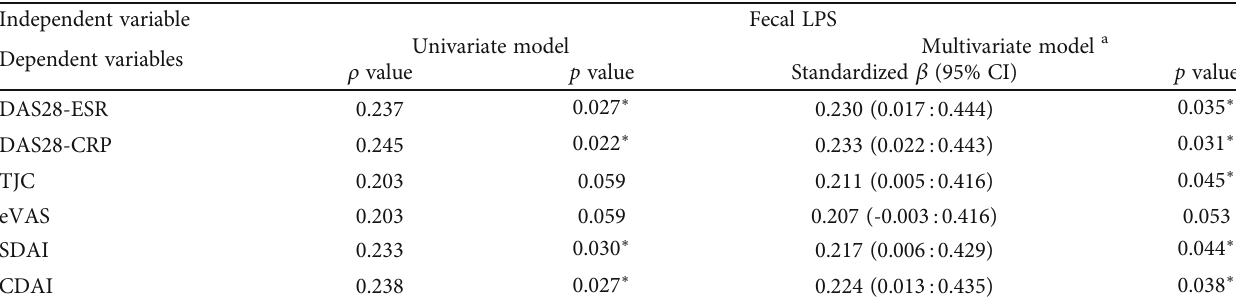
Table 3: Univariate and multivariate regression analyses between fecal LPS levels and RA activity indices.